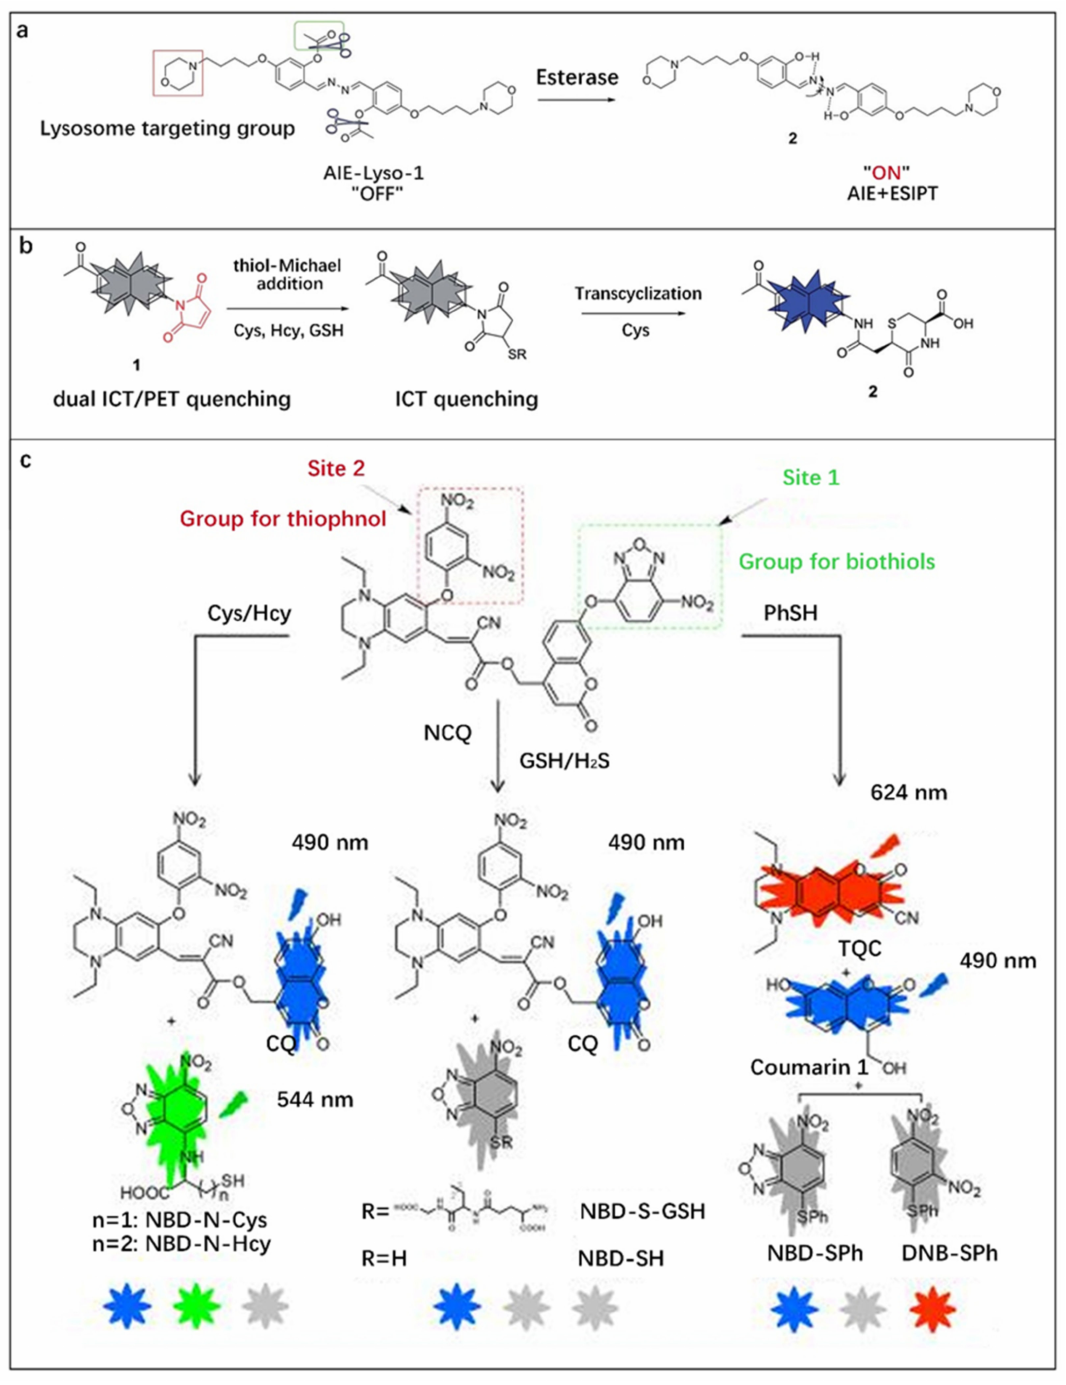
Figure 8. ( a ) Design of AIE-Lyso-1 for specific detection of lysosomal esterase. Reproduced with permission from Ref. [80], copyright 2014, Royal Society of Chemistry. ( b ) Design principle of